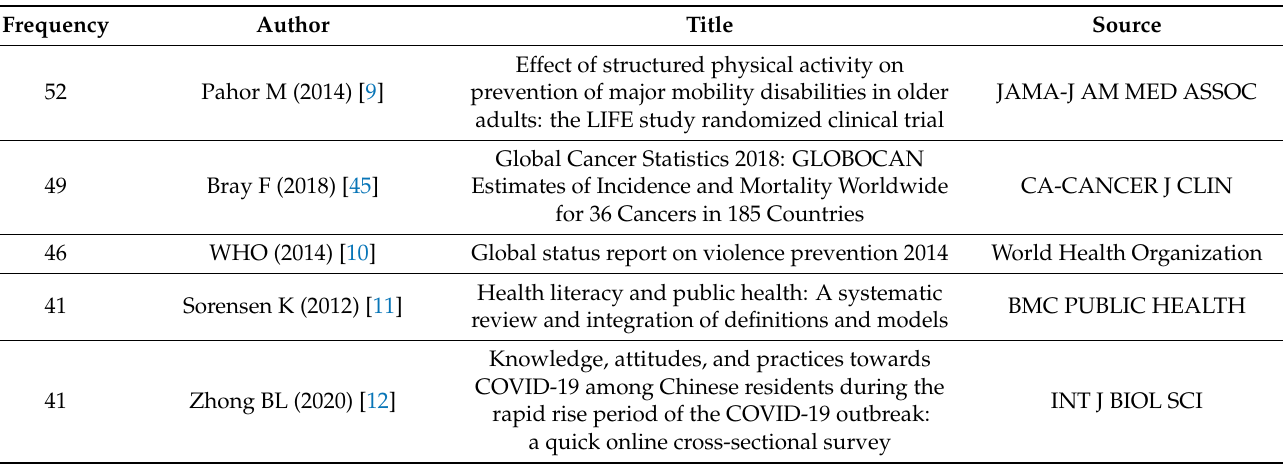
Table 3. The five top-cited articles in